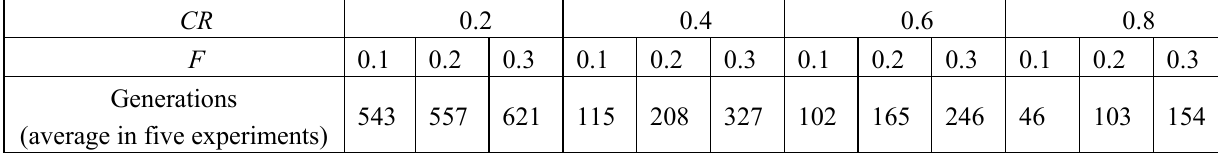
Table 1. Impact of Crossover and Variation Factors on the Evolution Generations.